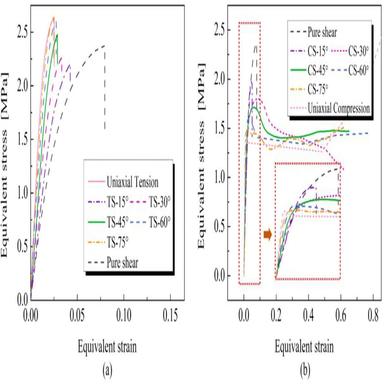
The tension-shear and compression-shear responses of PMI foam material with density of 0.075 g/cm3. (a) The equivalent stress-strain responses of PMI foam under combined tension-shear loads; (b) The equivalent stress-strain responses of PMI foam under combined compression-shear loads.